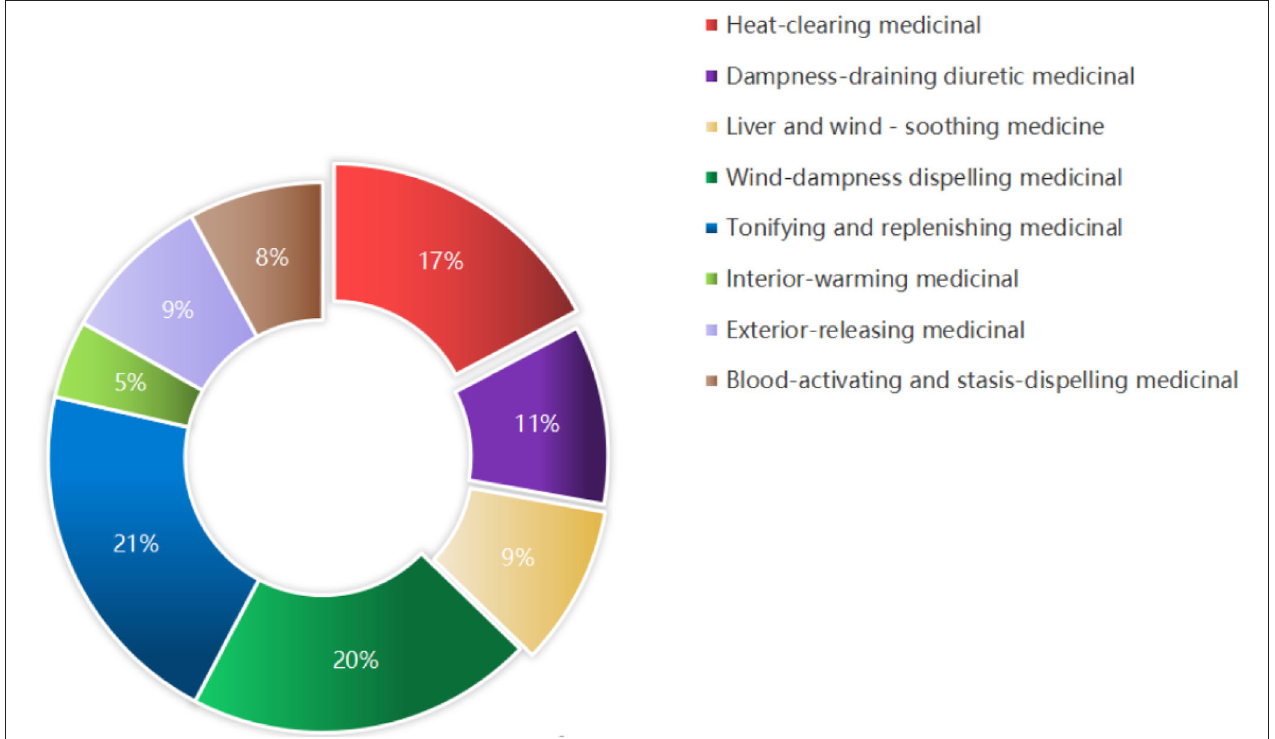
FIGURE 5 | Different classifications of high frequency used herbs. Sixteen kinds of high frequency used herbs were classified into eight categories with their